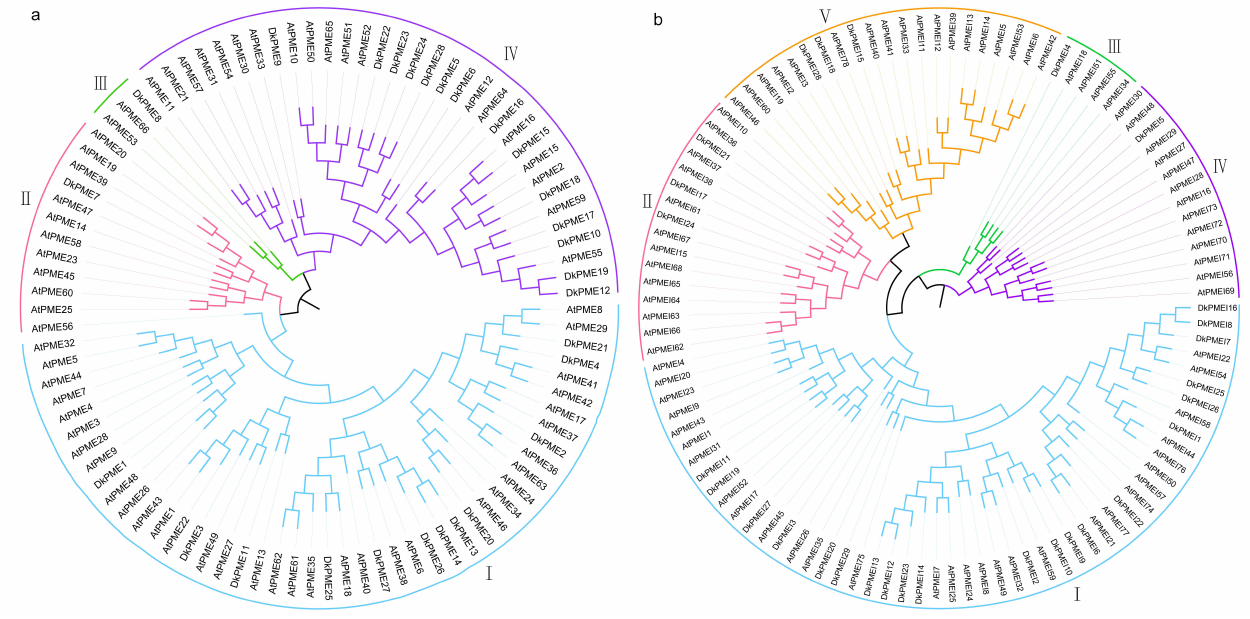
Figure 1. Phylogeny of the PME/PMEIs in D. kaki . ( a ) NJ phylogenetic tree of the DkPMEs; ( b ) NJ phylogenetic tree of the